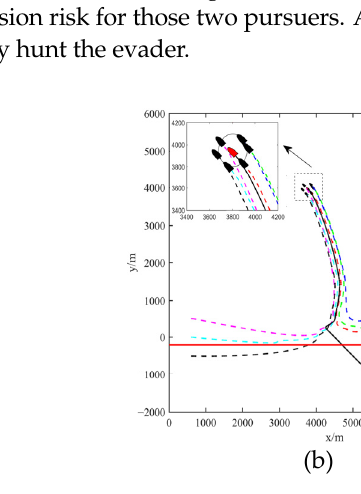
Figure 8. Pursuit − evasion simulations with dynamic obstacle ships. ( a ) t = 300 s; ( b ) t = 600